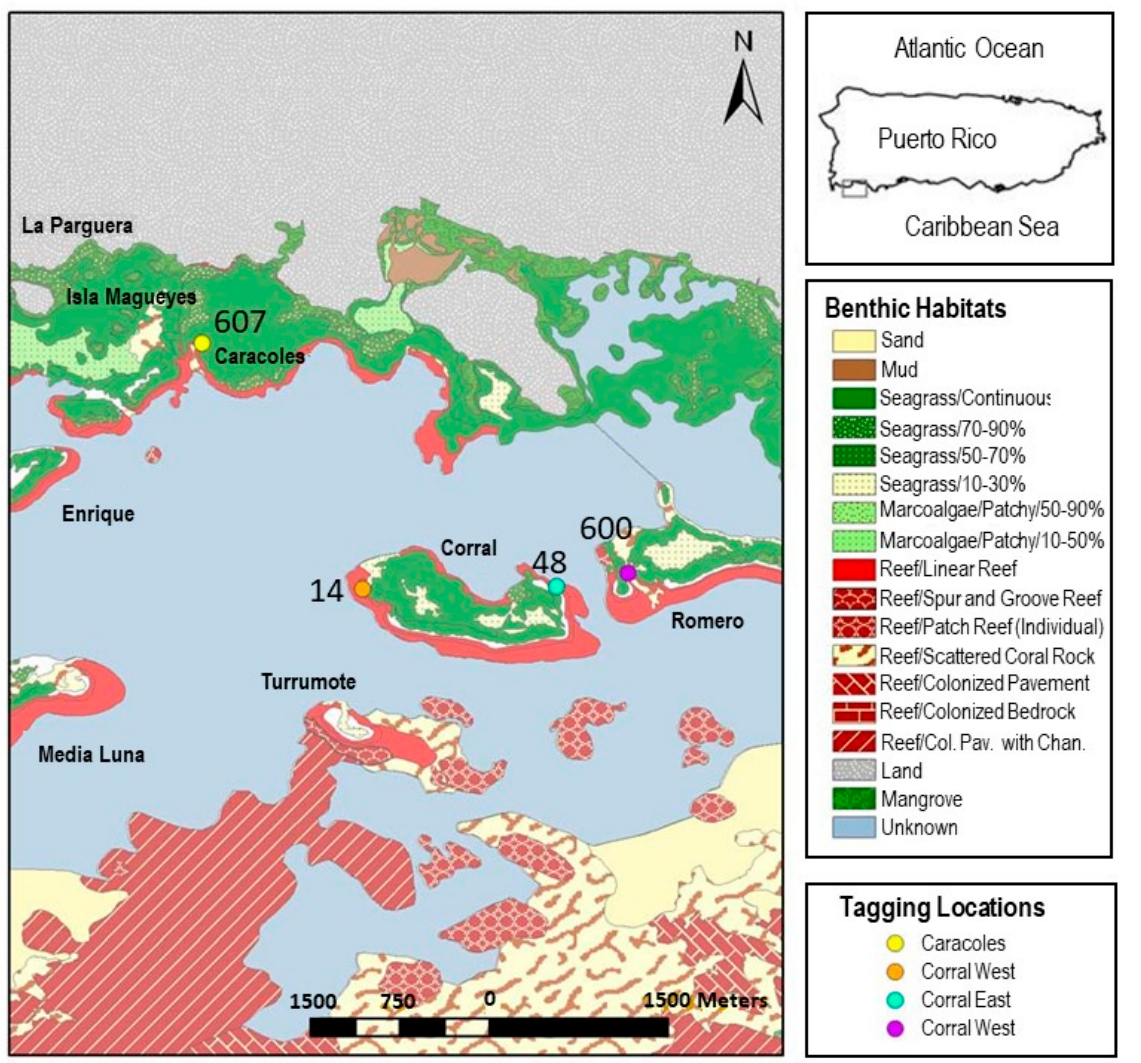
Figure 2. La Parguera, Puerto Rico showing benthic habitats (from Kendall et al. [37]) and the tagging locations of Haemulon flavolineatum located on the three reefs used in the study. Numbers indicate the number of fish tagged at each site for the study of large-scale juvenile movement.